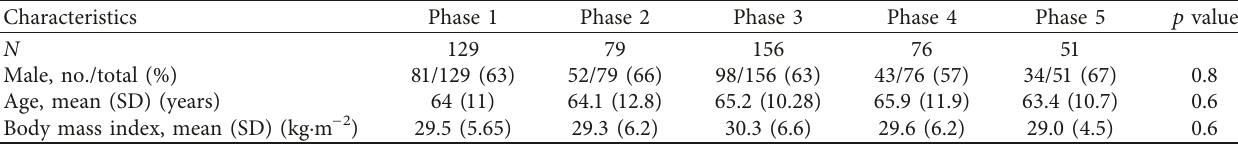
Table 2: Patient characteristics of phase-specific populations.